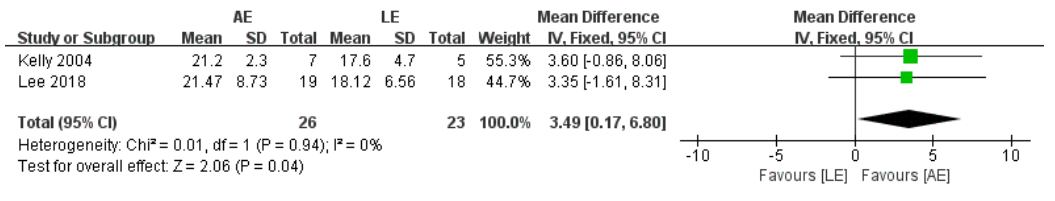
Figure 7. Forest plot: effects of VO 2 peak.